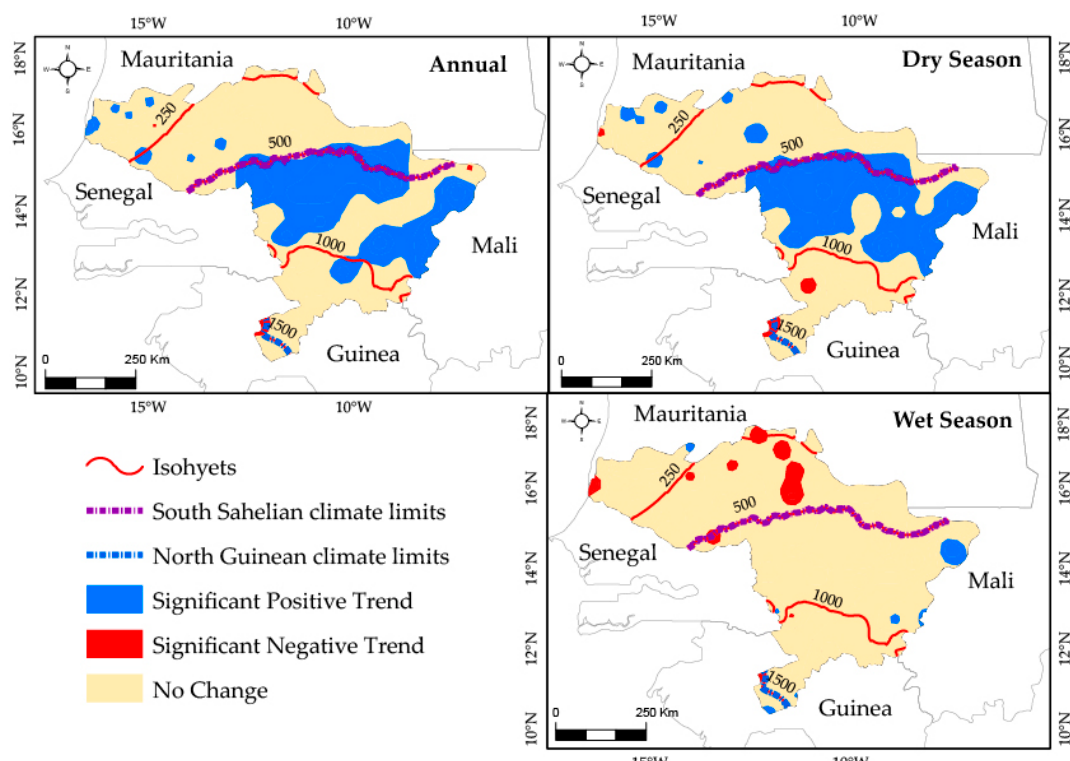
Figure 5. Spatial distribution of Mann-Kendall’s Z for annual and seasonal evapotranspiration over 1984 − 2017.